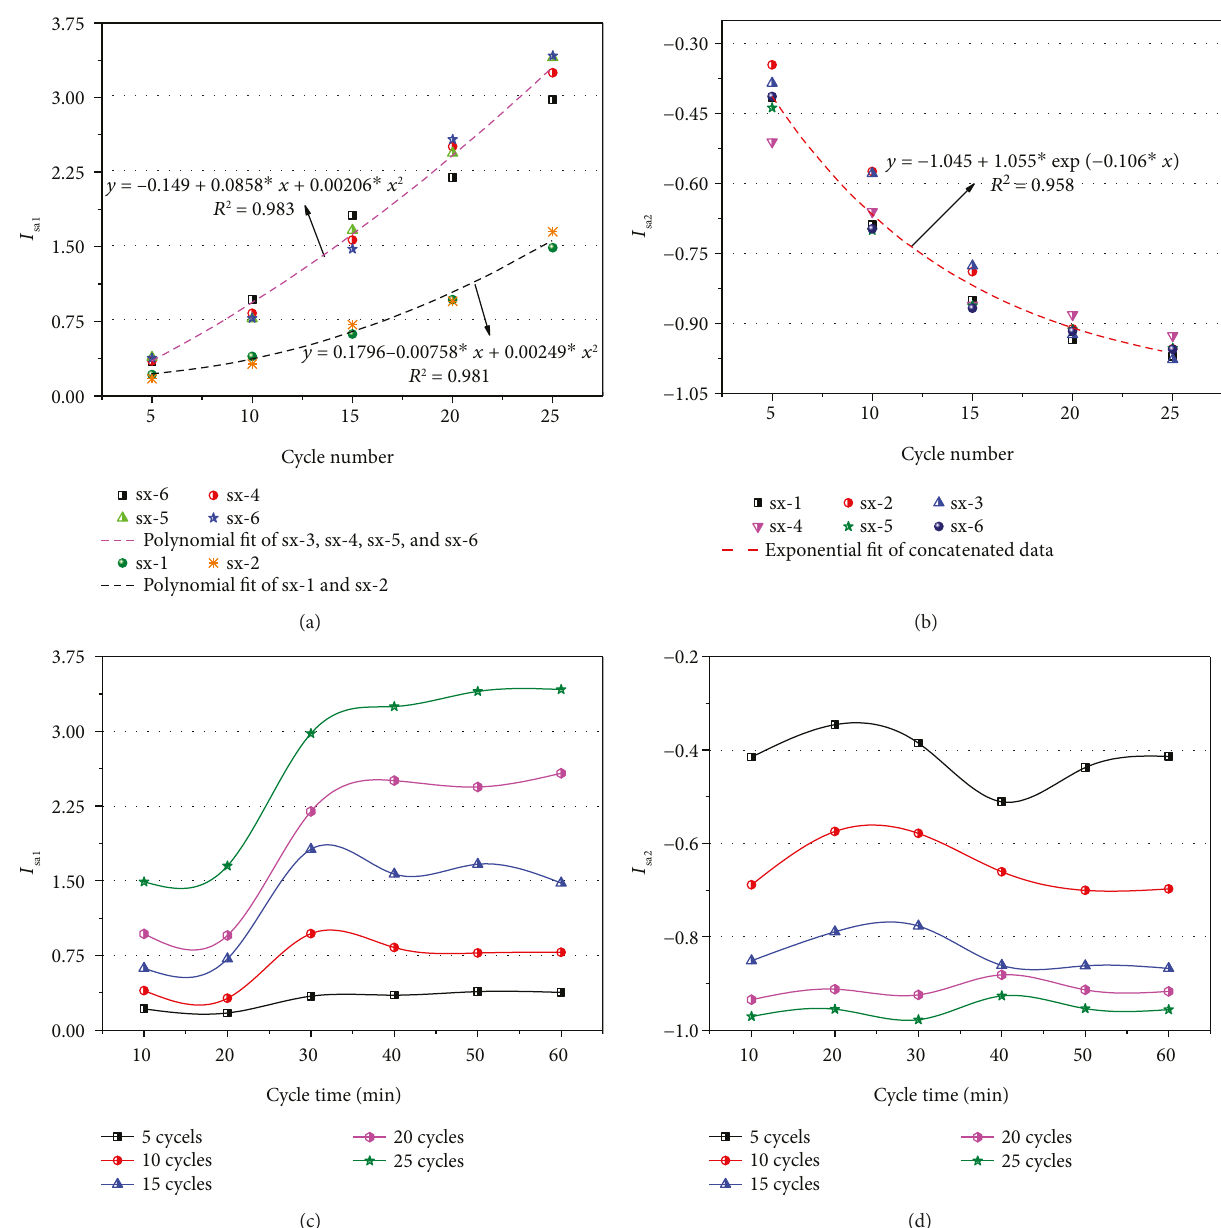
Figure 7: Variations of I